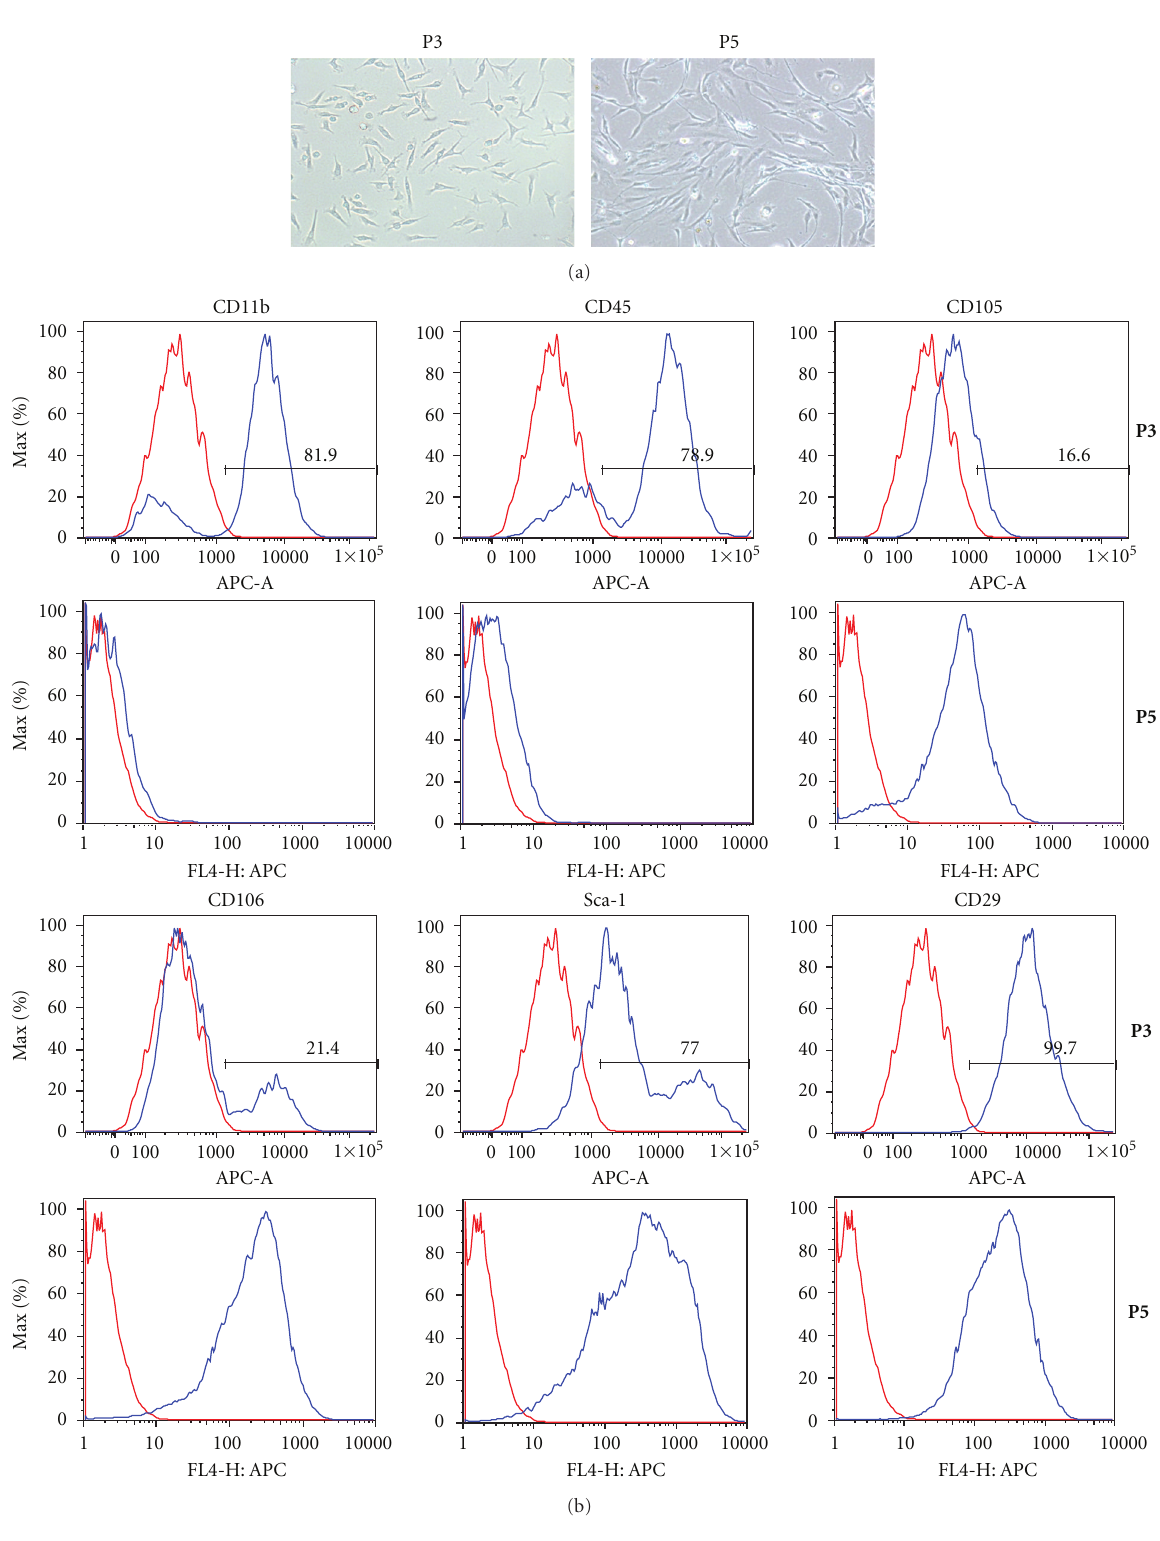
Figure 1: Characterization of the mouse bone marrow derived stem cells. The bone marrow derived stem cells were isolated by magnetic cell sorting using a Lin − cocktail of antibodies as well as stem cell antigen-1 (Sca-1) antibody and then cultured in the regular stem cell culture medium. (a) The cells were observed by phase contrast microscopy at passage 3 (left) or passage 5 (right). The cells at passage 5 became more fibroblastic appearing compared to passage 3. (b) Flow cytometry was utilized to examine the surface markers of cells at passage 3 (top panels) or passage 5 (bottom panels) for the purity of cell